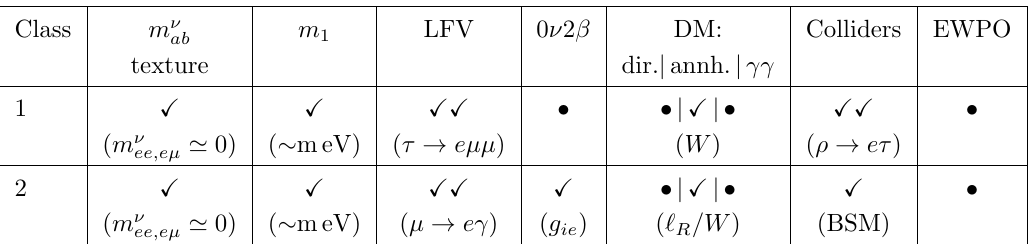
Table 3 . Summary of phenomenological signatures: ( tions and ( XX ) for striking signatures speci(cid:12)c to Class 1 or Class 2 scenarios. m (cid:23) neutrino mass matrix has a characteristic texture structure in the (cid:13)avour basis. m 1 : mass of the lightest neutrino. LFV: characteristic lepton (cid:13)avour violating processes. 0 (cid:23) 2 (cid:12) : neutrinoless double (cid:12) -decay signal. DM: dark matter signal in direct detection experiments (dir.), indirect DM annihi- lation (annh., with dominant annihilation channel) and monochromatic gamma-ray line signature ( (cid:13)(cid:13) ). Colliders: expected generic (BSM) or characteristic signatures. EWPO: electroweak precision